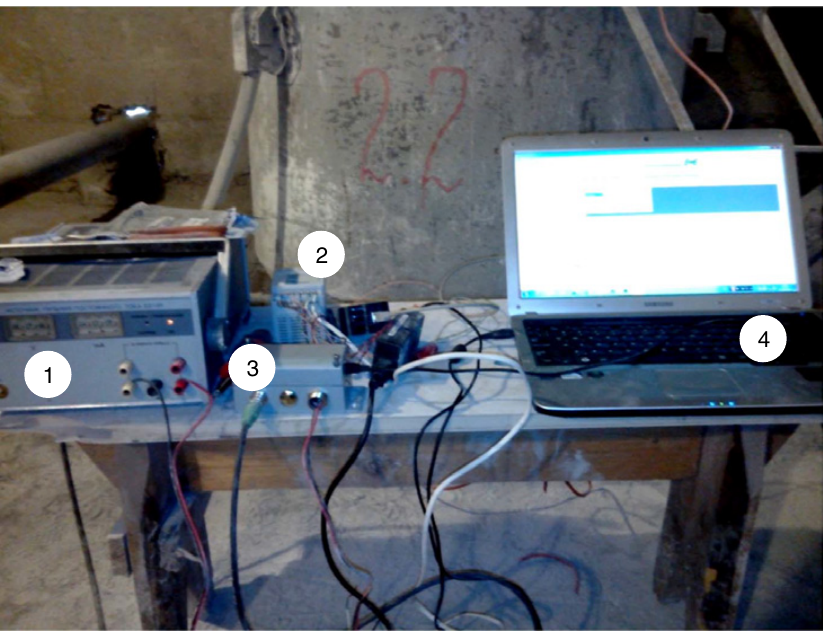
Figure 3. Device collect and process data: 1 – power supply unit; 2 – Digital Module input – output pressure sensors; 3 – module discrete input-output data flow meter; 4 –